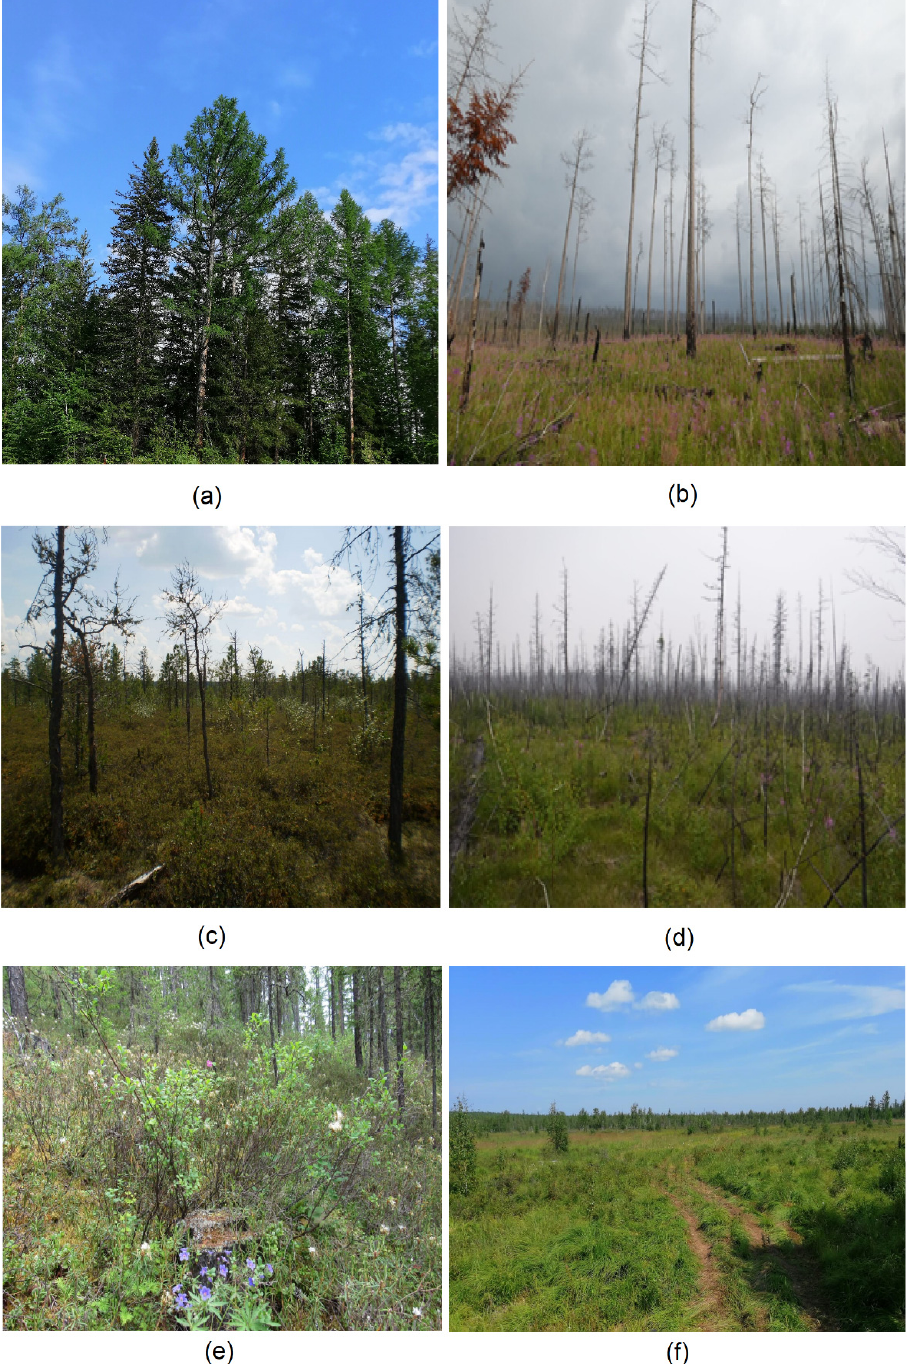
Figure 4. Examples of taiga landscapes: ( a ) coniferous forest; ( b ) forest burned in 2019; ( c ) tundra or mar’ (swampy forest); ( d ) swampy forest burnt in 2018; ( e ) navolok ; ( f ) kaltus .